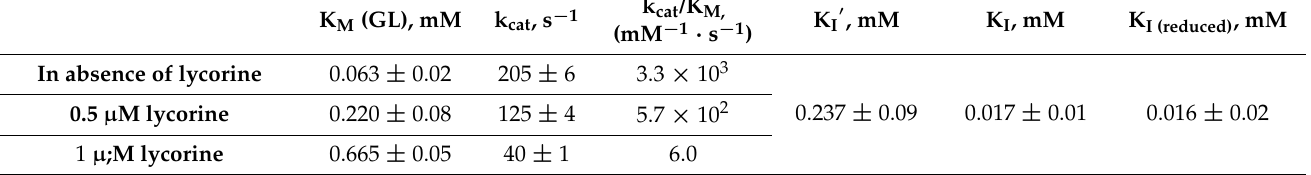
Table 4. Catalytic parameters of the systems used to determine the mechanism of inhibition. Con- centration of L -galactone-1,4-lactone was varied in the range of 0.12–1.01 mM at fixed inhibitor concentrations (0, 0.5, and 1 mM). The concentration of AtGALDH was 6 × 10 − 9 M;. Values are presented as the mean ± SD of three